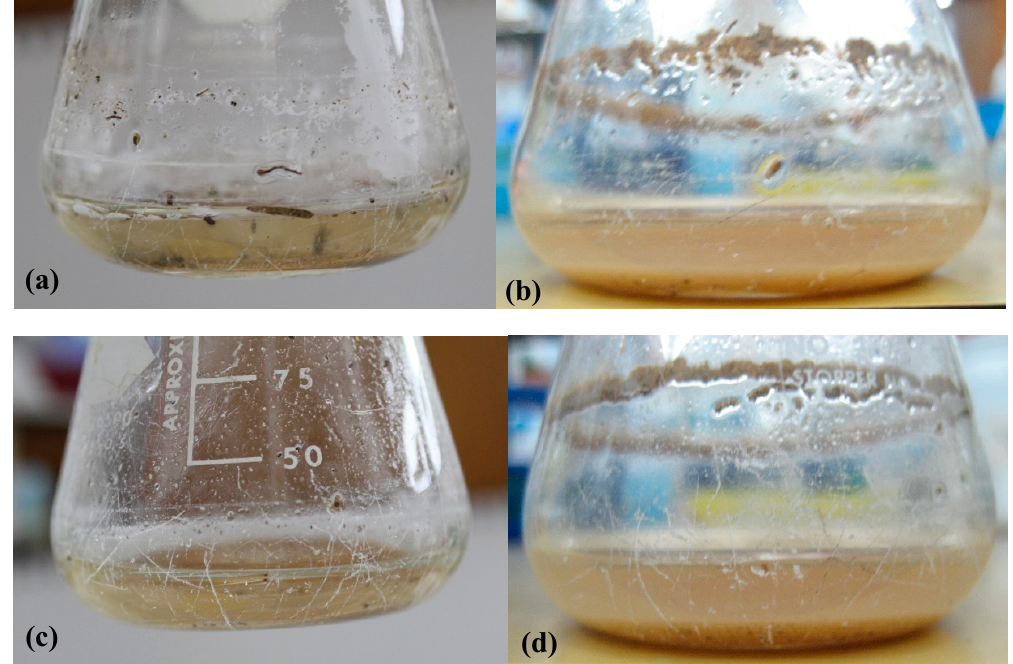
Figure 1. Flasks containing Davis minimal medium, soil samples, and epoxy resins before ( a , c ) and after ( b , d ) one-week incubation. ( a , b ) LY 5052 epoxy resin; ( c , d ) 815C epoxy resin.